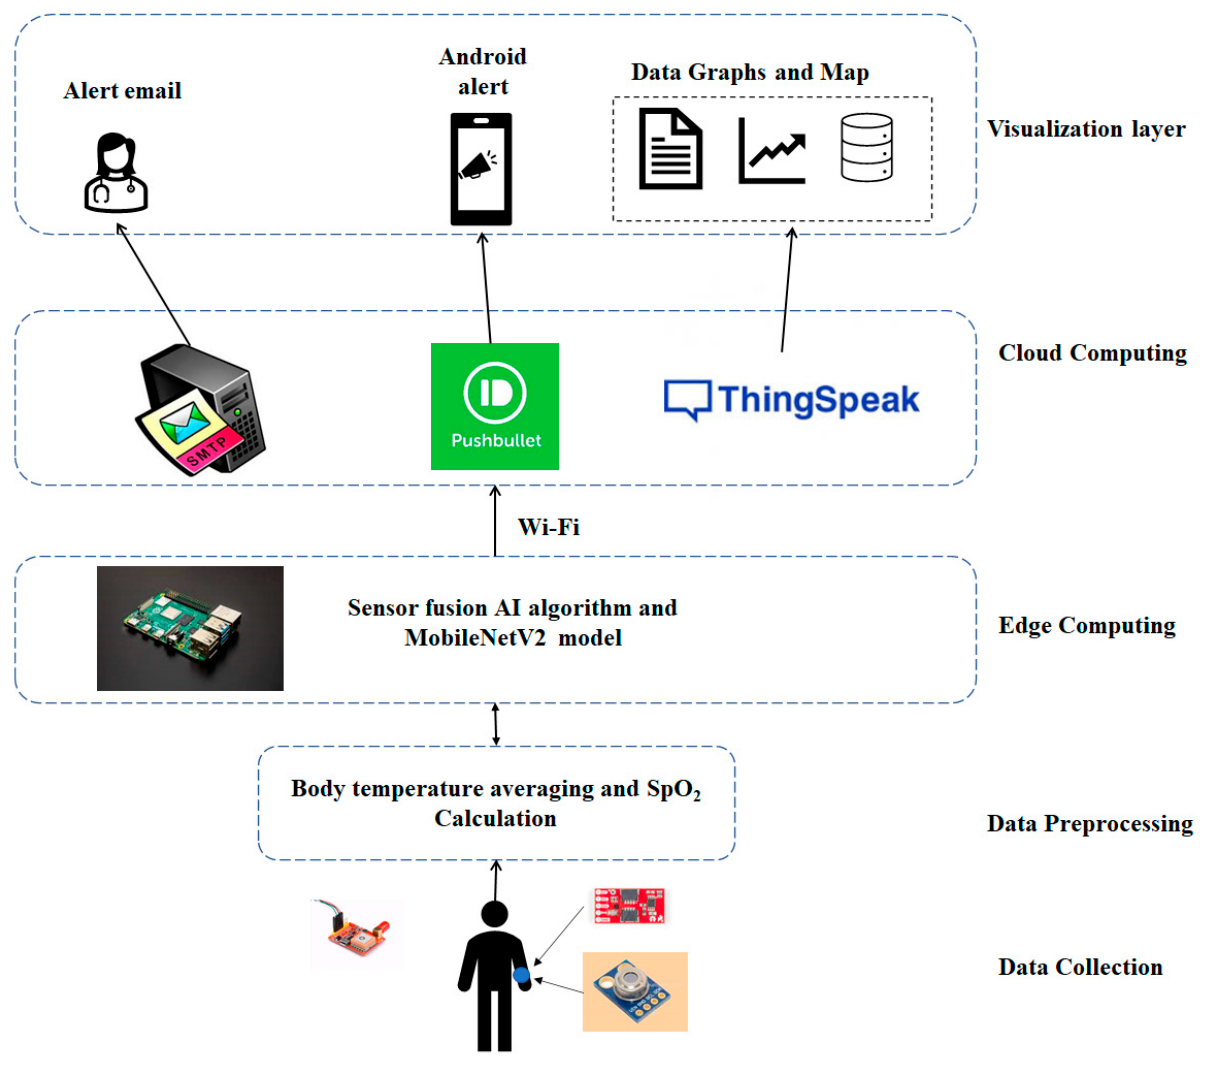
Figure 1. The overall architecture of the proposed IIOT device.